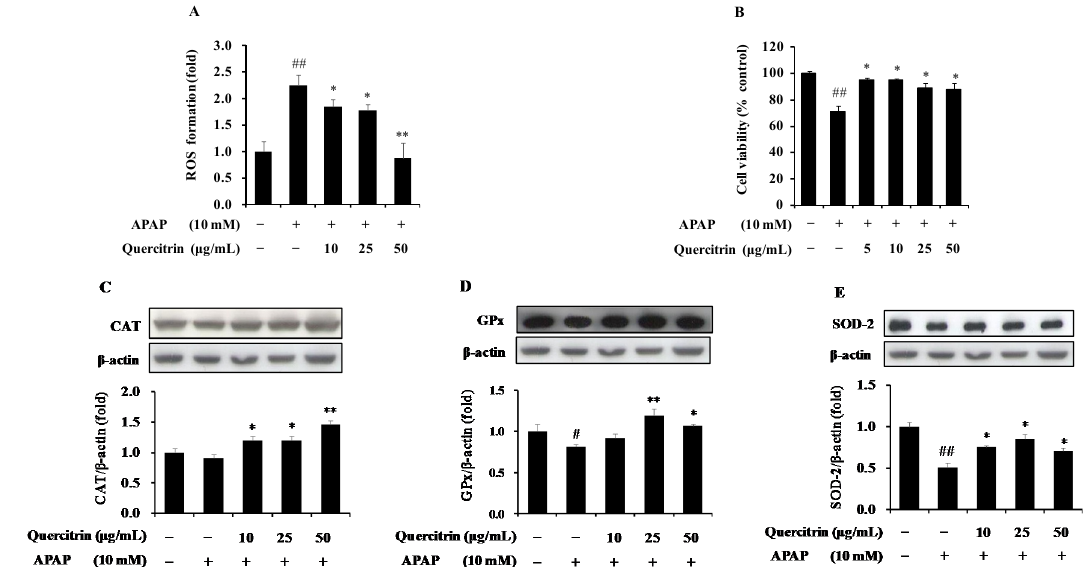
Figure 2. Protective effects of quercitrin on acetaminophen (APAP)-treated HepG2 cells. ( A ) Effect of quercitrin on APAP-mediated reactive oxygen species (ROS) formation; ( B ) Effect of quercitrin on cell viability using MTT assay at 24 h. Effect of quercitrin on protein expressions of ( C ) catalase (CAT); ( D ) glutathione peroxidase (GPx); and ( E ) superoxide dismutase 2 (SOD-2) in APAP-treated HepG2 cells. ROS was presented as the fold induction of vehicle-treated control. Cell viability was normalized as 100% for control (without any treatments). Protein expression levels were normalized with β -actin. All data represent means ± SD of at least three independent experiments. Significant differences were ( ## ) p < 0.01 or ( # ) p < 0.05 as compared with the control; (**) p < 0.01 or (*) p < 0.05 as compared with the APAP group.